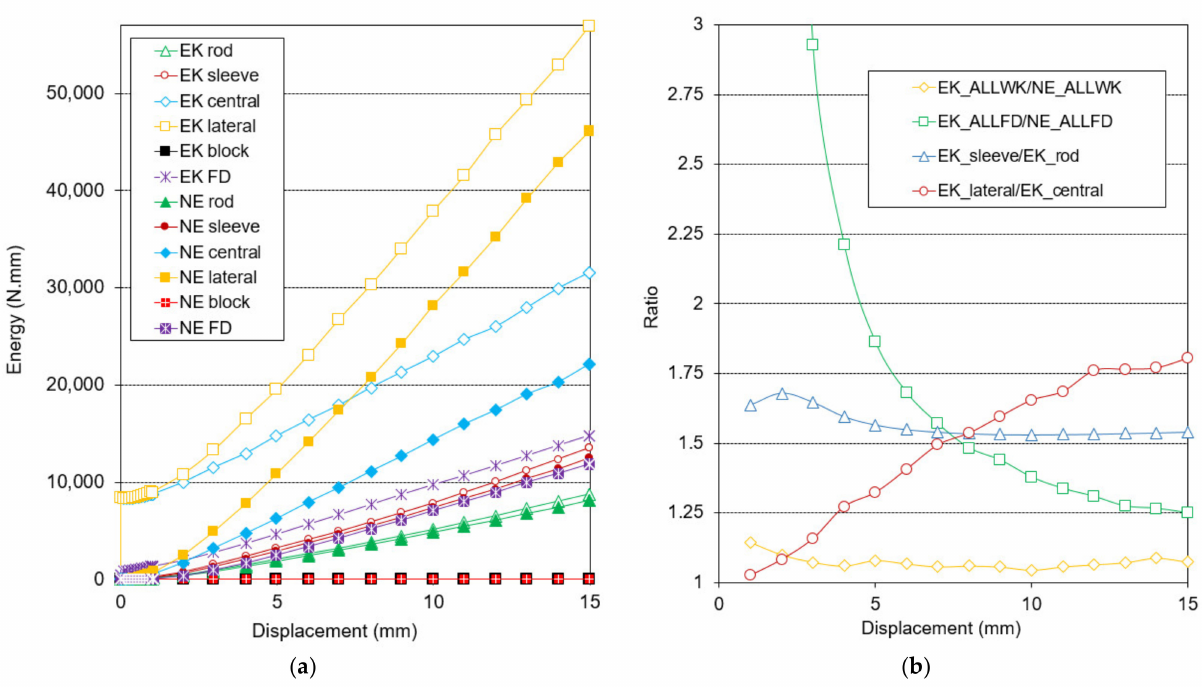
Figure 12. Mechanical energy distribution and energy ratios between the different joint parts. ( a ) Energies (N.mm) and ( b ) ratios between